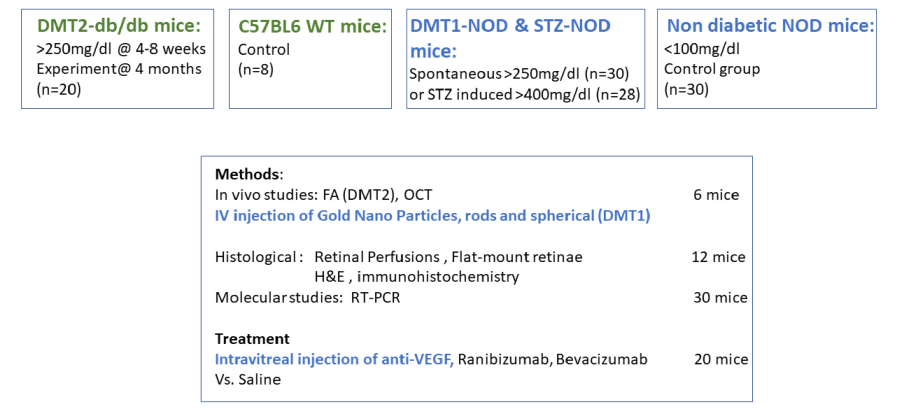
Figure 1. Experimental design of the study. Mice groups, study methods, and treatments are described in brief.